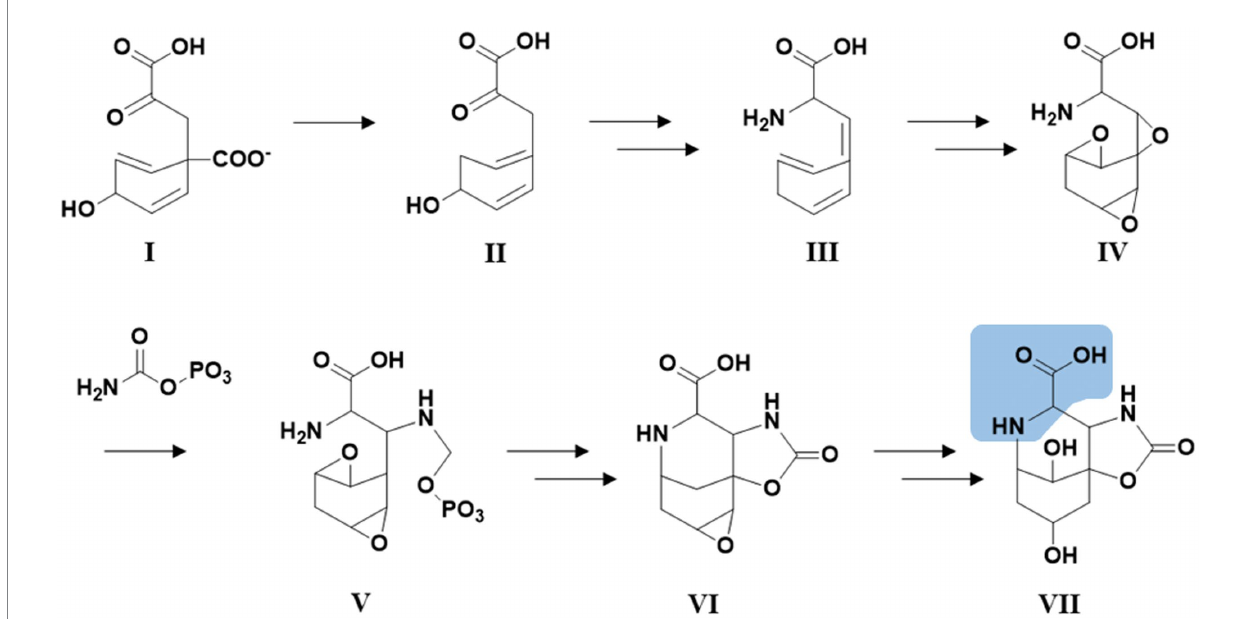
FIGURE 5 Hypothetical biosynthetic pathway for the Abn moiety (VII) based on Pluotno and Carmeli (2005) but starting from prephenate (I). Structural feature highlighted in blue: The structural features of VII which are distantly similar to